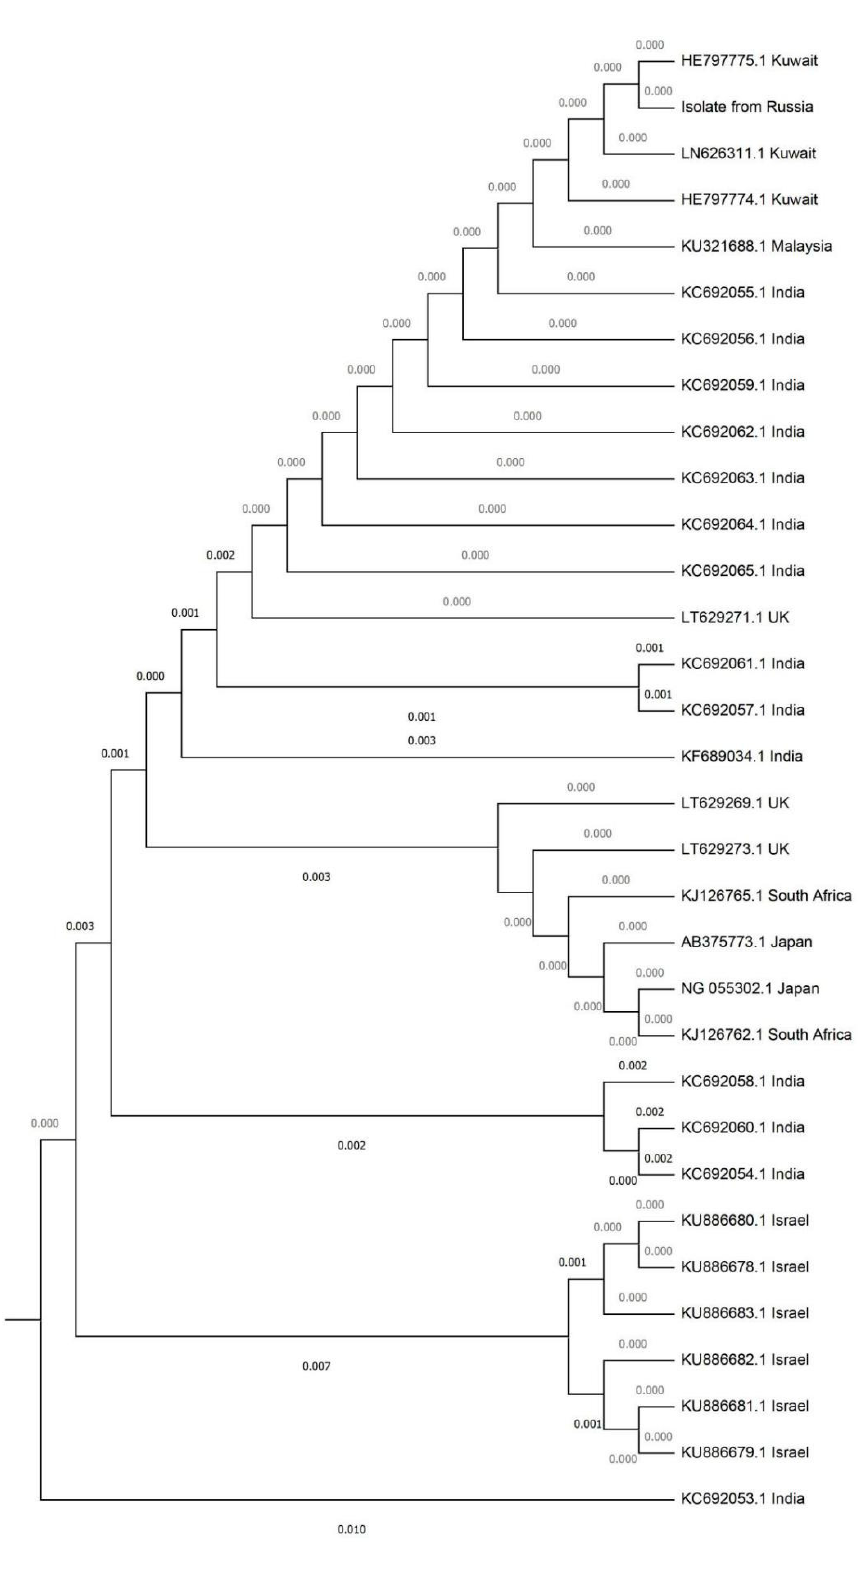
Figure 2. Phylogenetic tree of D1-D2 domain.